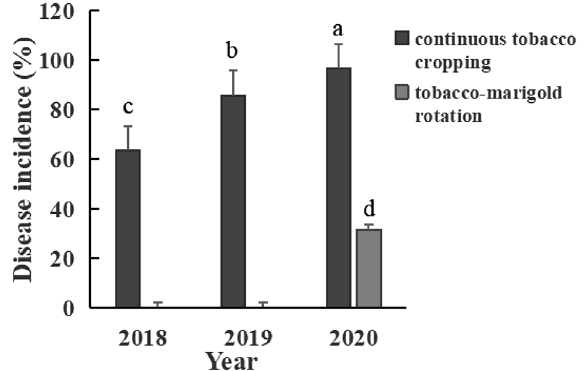
Figure 8. Effect of marigold crop rotation on the incidence of root-knot nematodes disease at